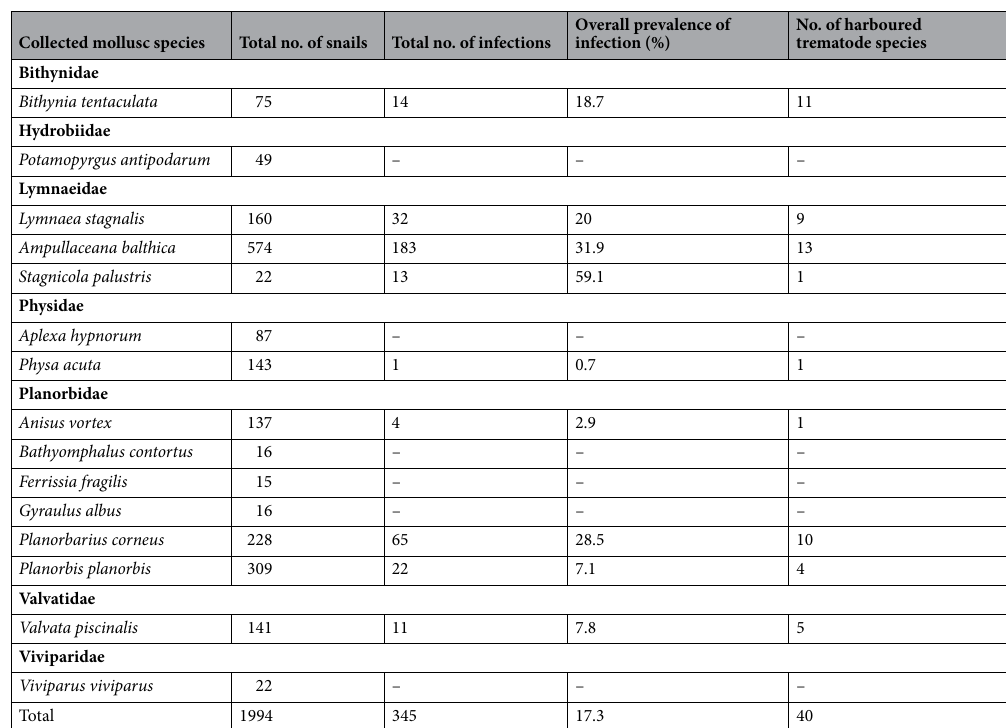
Table 1. Overview of collected mollusc species, number and prevalence of infection, and the number of harboured trematode species.